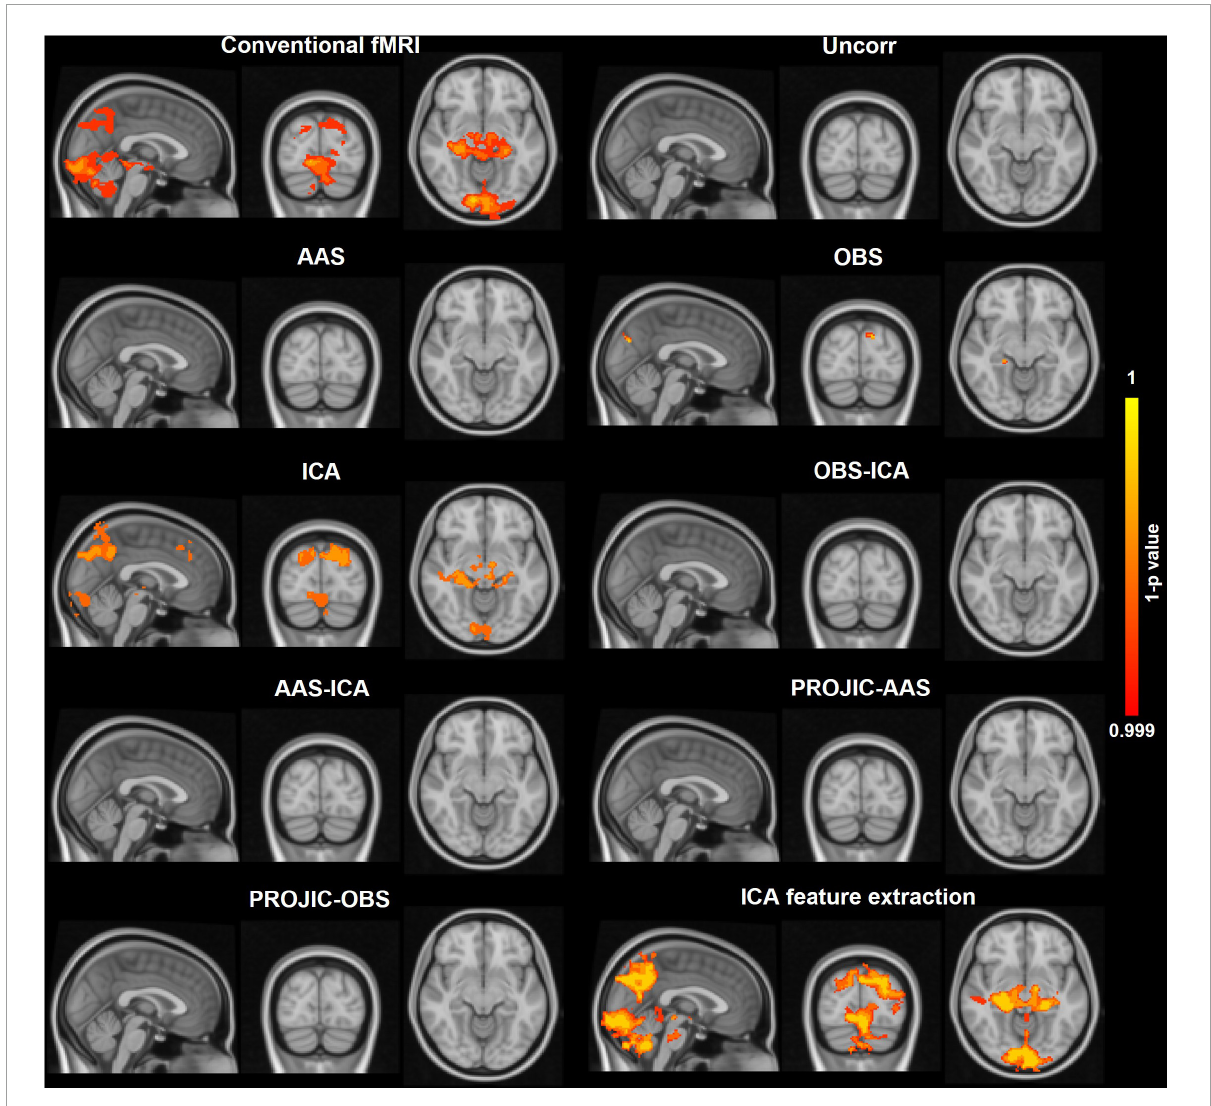
FIGURE7 Corrected threshold-free cluster enhancement voxel-wise group-level statistical maps obtained from the EC-EO task fMRI data analysis ( n = 15) using either the task design or the EEG alpha power fluctuations to generate the blood-oxygen level-dependent (BOLD) signal predictors used in the general linear model. For the conventional fMRI analysis (task design), the map shows the voxels that displayed a positive association with the model (higher BOLD signal in EO vs. EC conditions). For the EEG-informed fMRI analyses, the maps show the voxels where the BOLD signal exhibited a significant negative association with the EEG alpha power derived BOLD signal predictor. A comparison is shown between the maps obtained using the predictors derived from the same EEG signals, corrected using each BCG correction method or IFE. Only IFE preserved the negative relationship between alpha power fluctuations and the BOLD signal, providing very similar maps to those obtained from the conventional fMRI analysis. The color scale shows the 1-p statistical values with a threshold set at p <